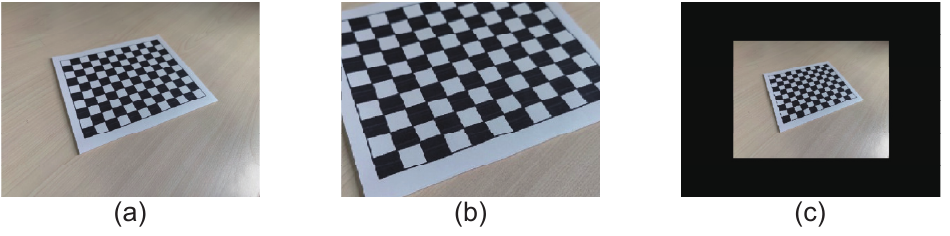
Figure 9. Scaling of the image. ( a ) is the original image, ( b ) is the enlarged image, set k h = k w = − 0.5, ( c ) is the reduced image, and set k h = k w = 0.2.